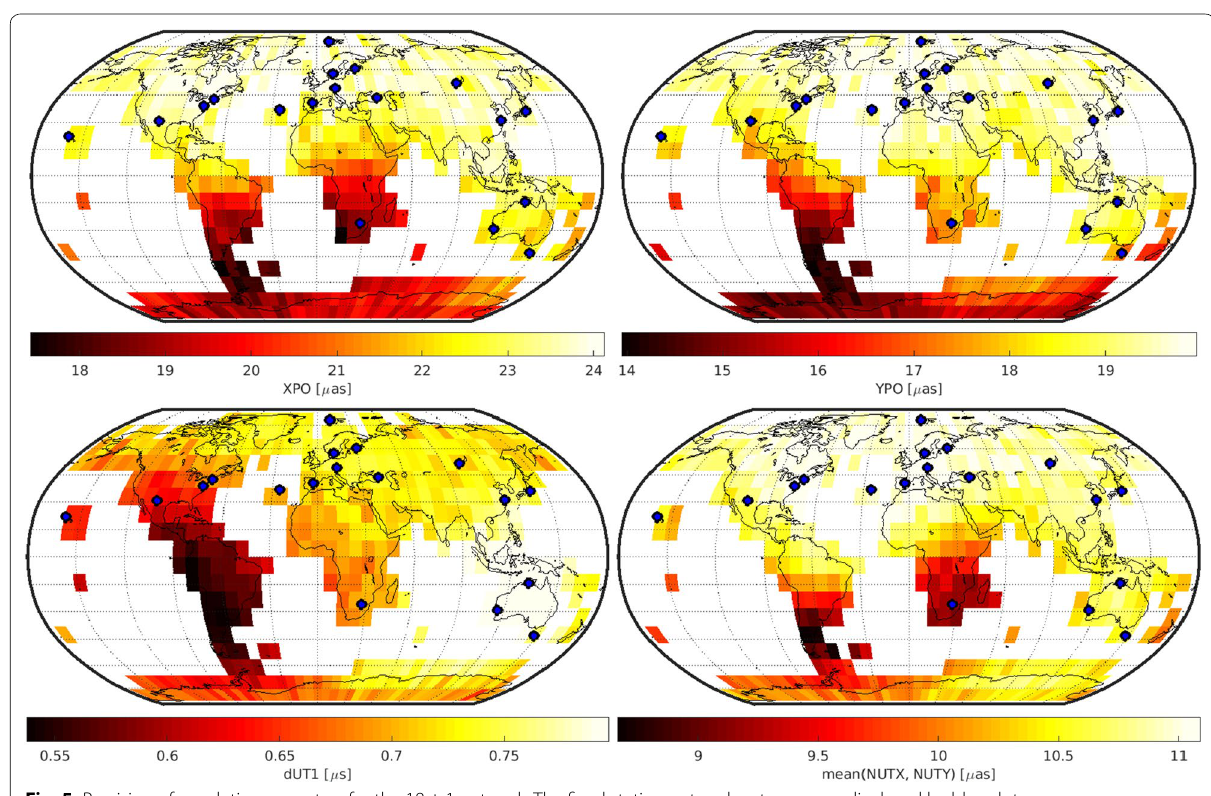
Fig. 5 Precision of geodetic parameters for the 18